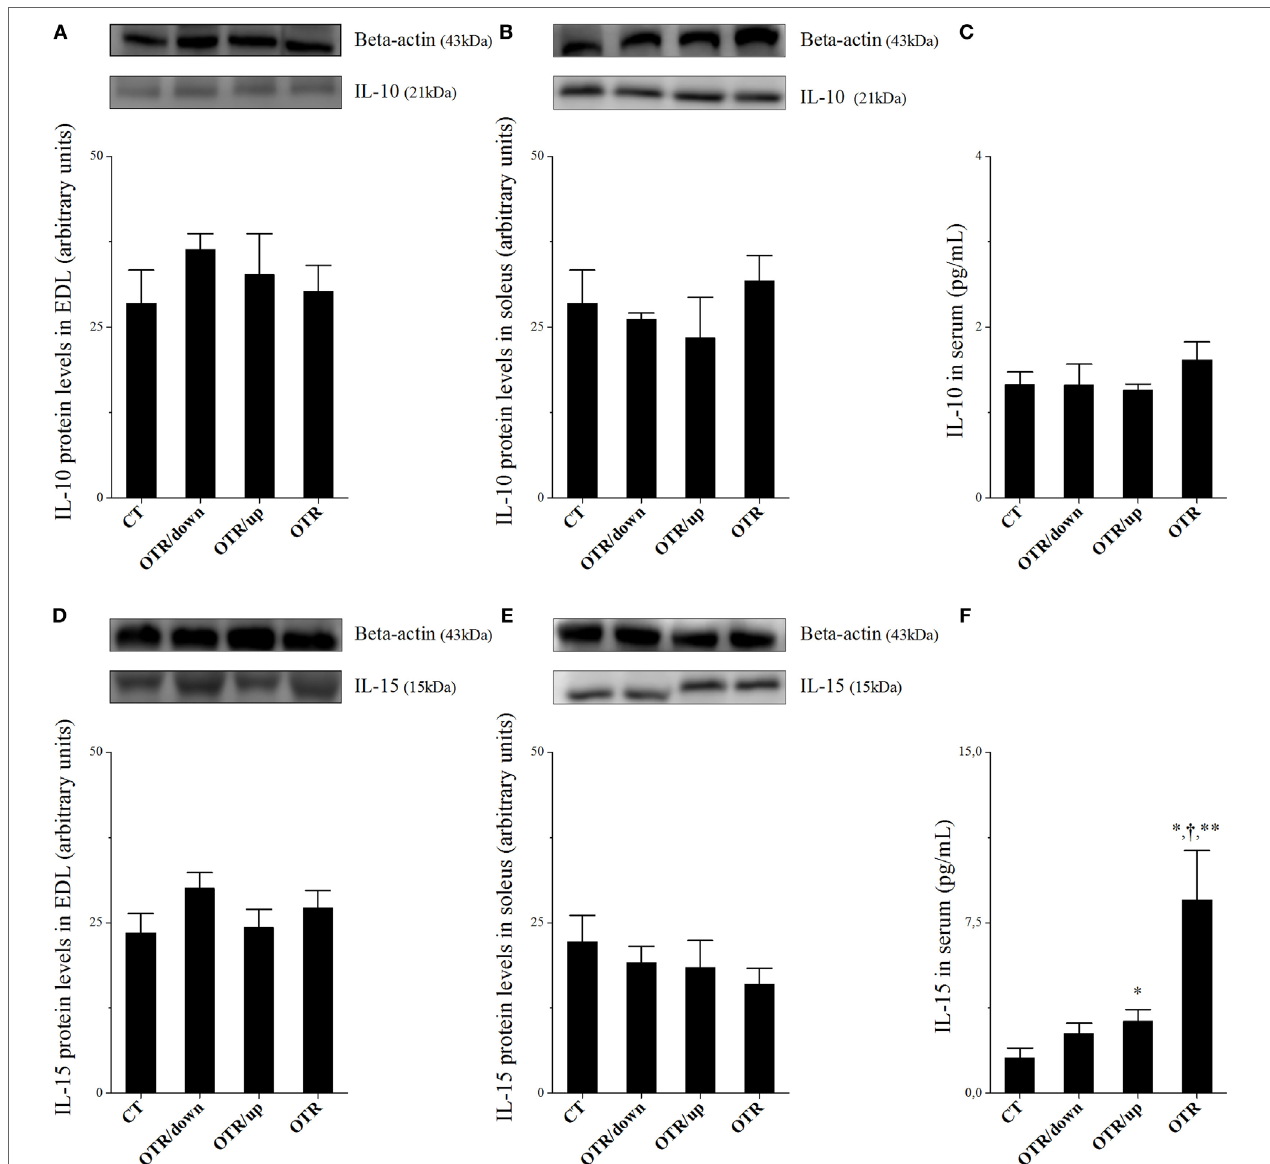
FigUre 2 | Protein levels (arbitrary units) of interleukin (IL)-10 in extensor digitorum longus (EDL) (a) , soleus (B) , and serum (c) ; IL-15 in EDL (D) , soleus (e) , and serum (F) . Data correspond to mean ± standard error (SE) of n = 6. Control (CT): sedentary mice. OTR/down: overtrained by downhill running. OTR/up: overtrained by uphill running. OTR: overtrained by running without inclination. * P < 0.05 vs. CT; † P < 0.05 vs. OTR/down; ** P < 0.05 vs.